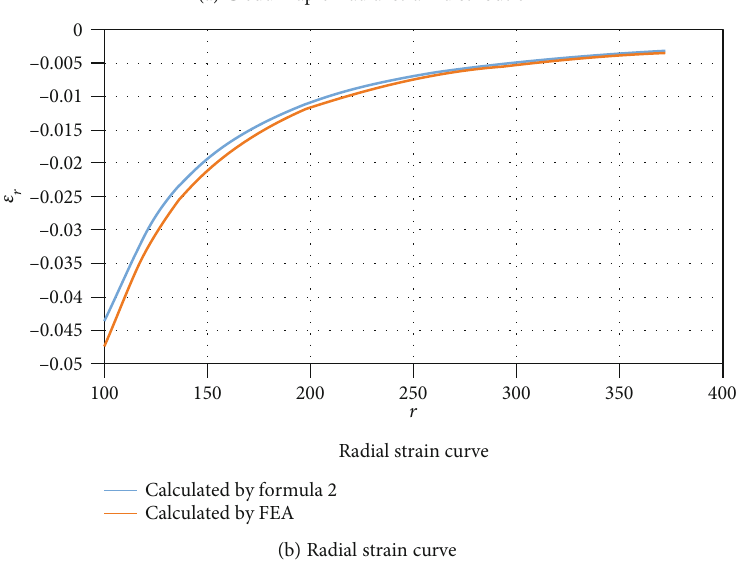
Calculated by formula 2 Calculated by FEA